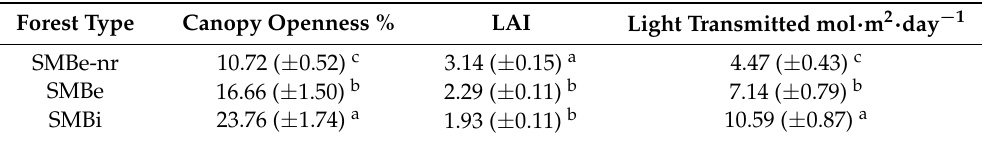
Table 2. Characteristics of the light environment in the three forest types